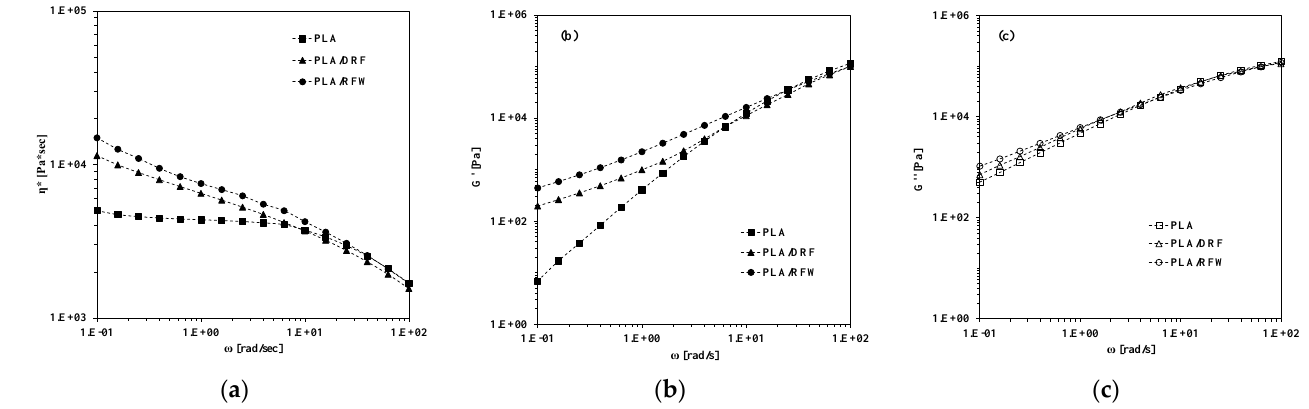
Figure 3. ( a ) Complex viscosity, η; ( b ) storage modulus, G’; and ( c ) loss modulus, G’’, of neat PLA and PLA containing 10%wt. of DRF and RFW.